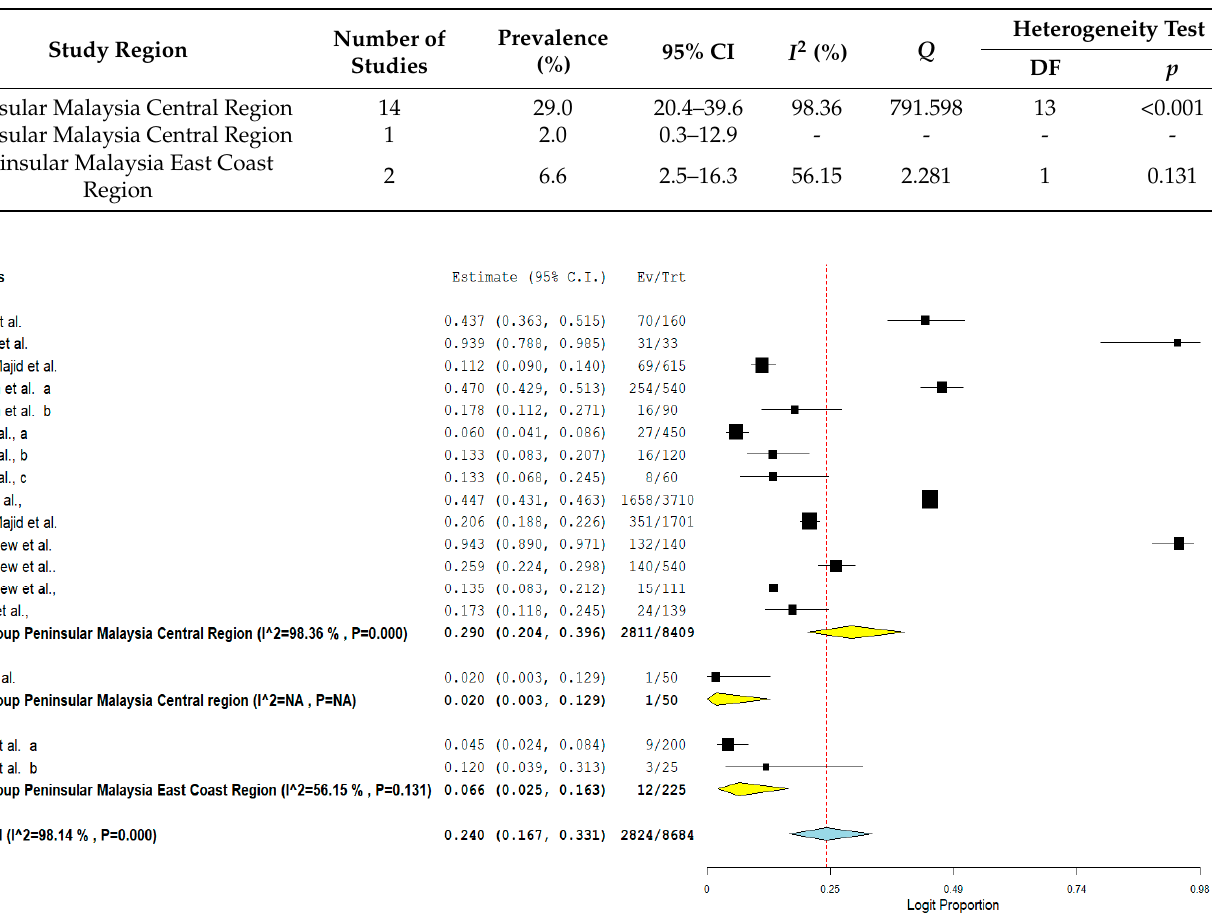
Table 4. Subgroup analysis for comparison of VRE in poultry in Malaysia across isolate